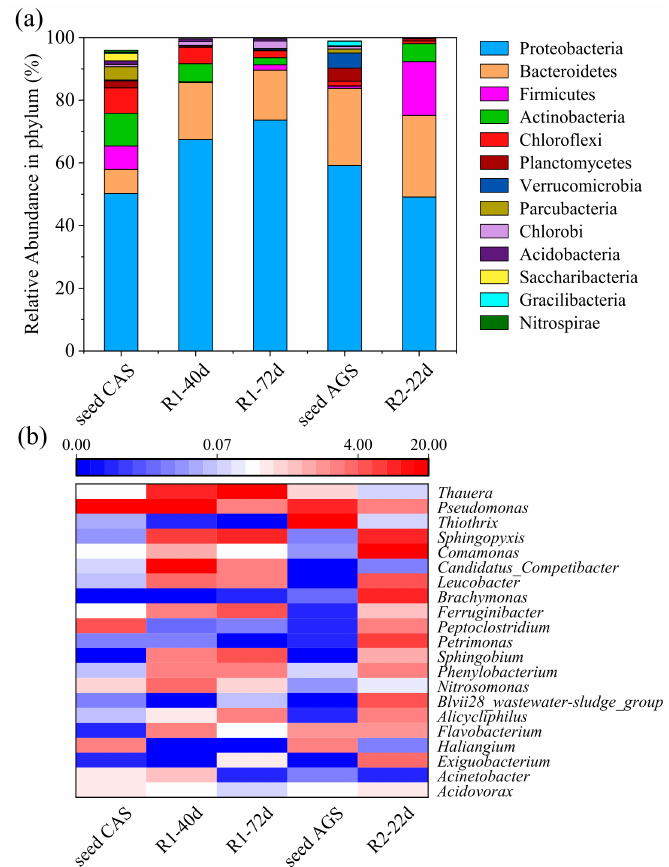
Figure 6. Microbial community characterization for seed CAS, sludge of R1-40d and R1-72, seed AGS, and sludge of R2-22d (( a ) relative abundance at the phylum level; ( b ) richness heat map of the microbial community at the genus